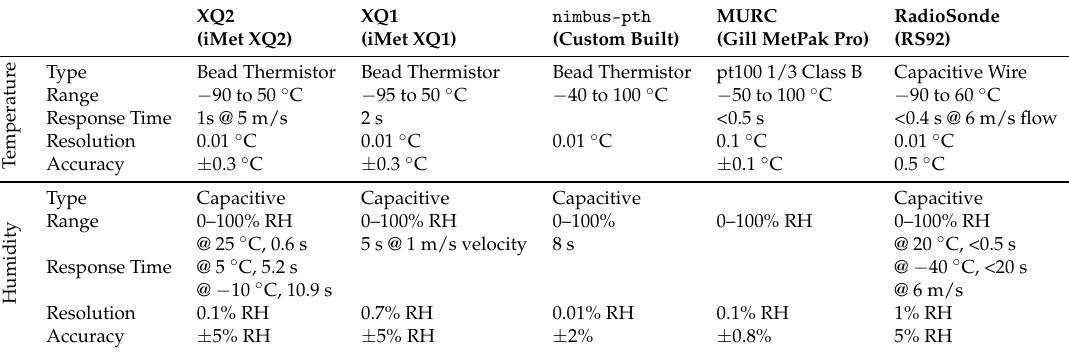
Table 2. The key specifications for the sensors used in different experiments: The unavailable fields are left blank.